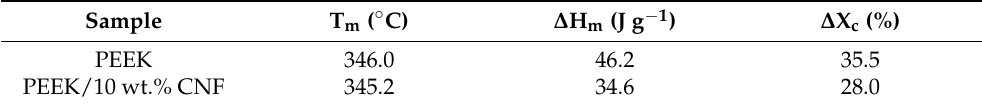
Figure 5. DSC thermographs of PEEK and PEEK/10 wt.% CNF composites (dotted lines are guides for the eyes). Table 1. DSC data of neat PEEK and PEEK/10 wt.% CNF composites corresponding to the second heating scans.